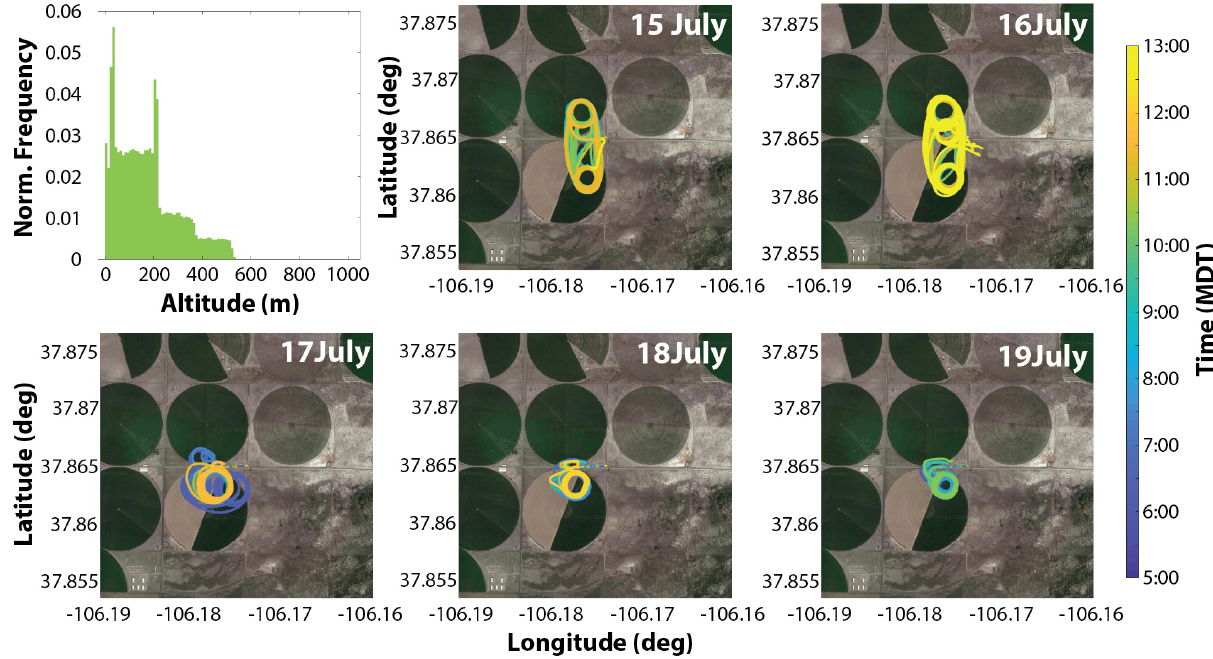
Figure 3. A histogram of altitudes covered during LAPSE-RATE by the DataHawk2 (top left), along with the flight patterns covered by this aircraft during individual days of the campaign. See the map in Fig. 2 for additional details on flight location. Map backgrounds are © Google Maps 2021 and downloaded through their